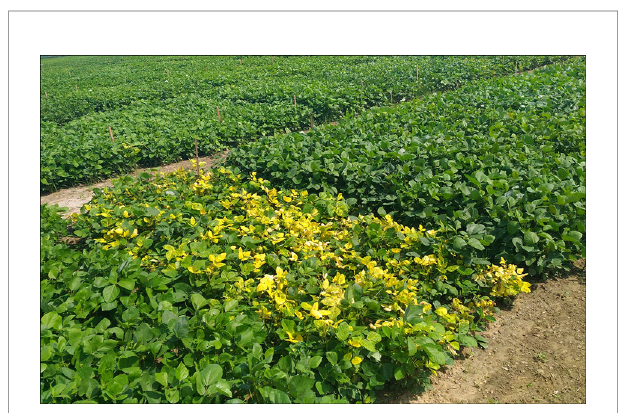
FIGURE 1 | Field view of YMD susceptible (yellowing of the plants) and resistant expression (normal green plants) in various mungbean